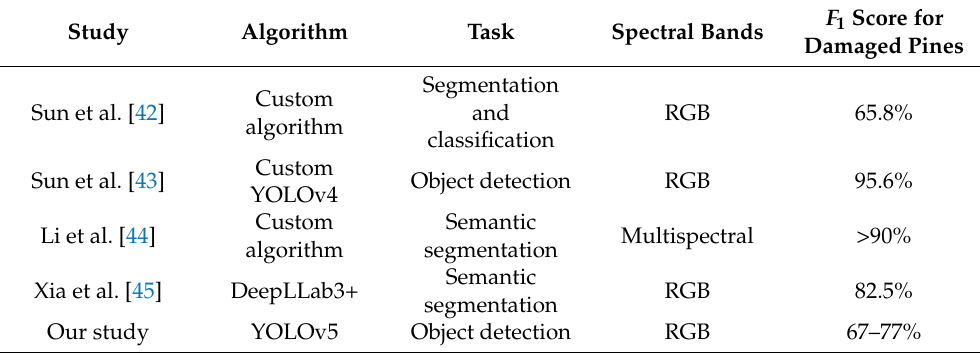
Table 3. Comparison of pine tree vitality monitoring studies utilizing the F 1 score as an evalua- tion